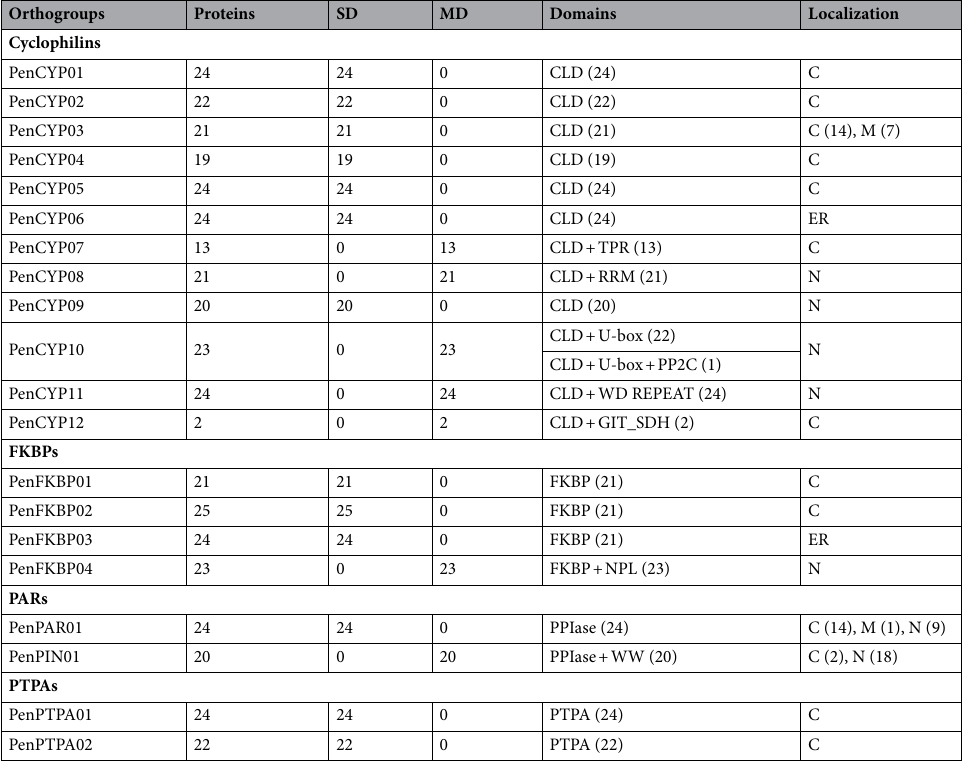
Table 3. Domain architecture and localization of different orthogroups of cyclophilins, FK506-binding proteins (FKBPs), parvulins and protein phosphatase 2A activators (PTPAs) in Penicillium spp. C: cytoplasm; CLD: cyclophilin-like domain; ER: endoplasmic reticulum; FKBP: FK506-binding protein; GIT_SDH: Spa2 homology domain (SHD) of GIT [G-protein-coupled receptor (GPCR)-kinase-interacting protein]; M: mitochondria; MD: multi-domain; N: nucleus; NPL: nucleoplasmin-like domain; PP2C: Protein phosphatase 2C; PTPA: protein phosphatase 2A activator; RRM: RNA recognition motif; SD: single domain; TPR: tetratricopeptide repeat; U-box: U-box domain; WD: tryptophan-aspartate repeats; WW: Domain with 2 conserved tryptophan